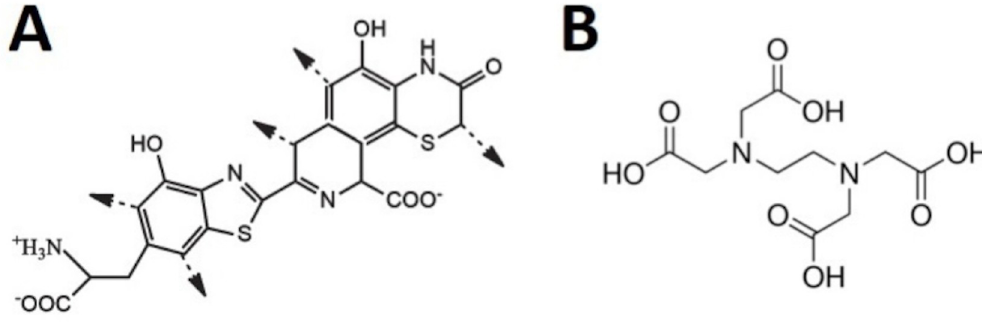
Fig 1. Chemical structures of (A) pheomelanin [44] and (B) EDTA